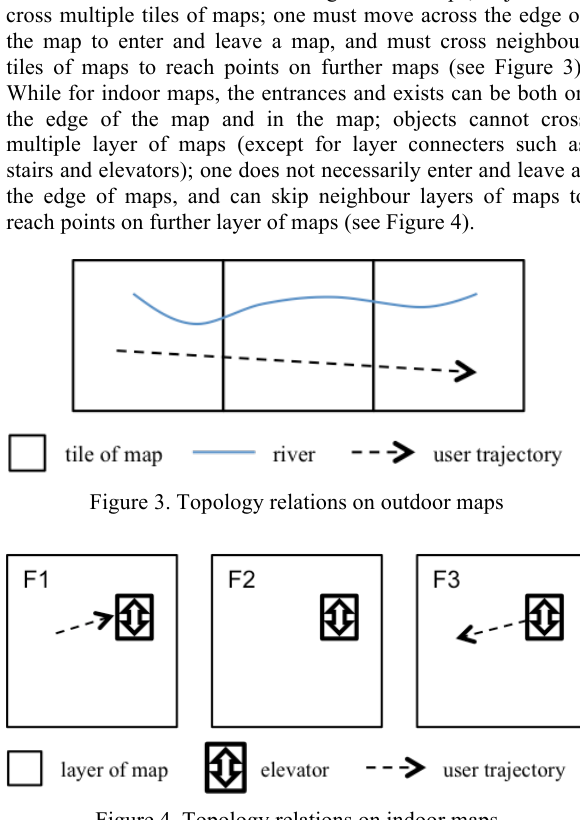
Figure 4. Topology relations on indoor maps